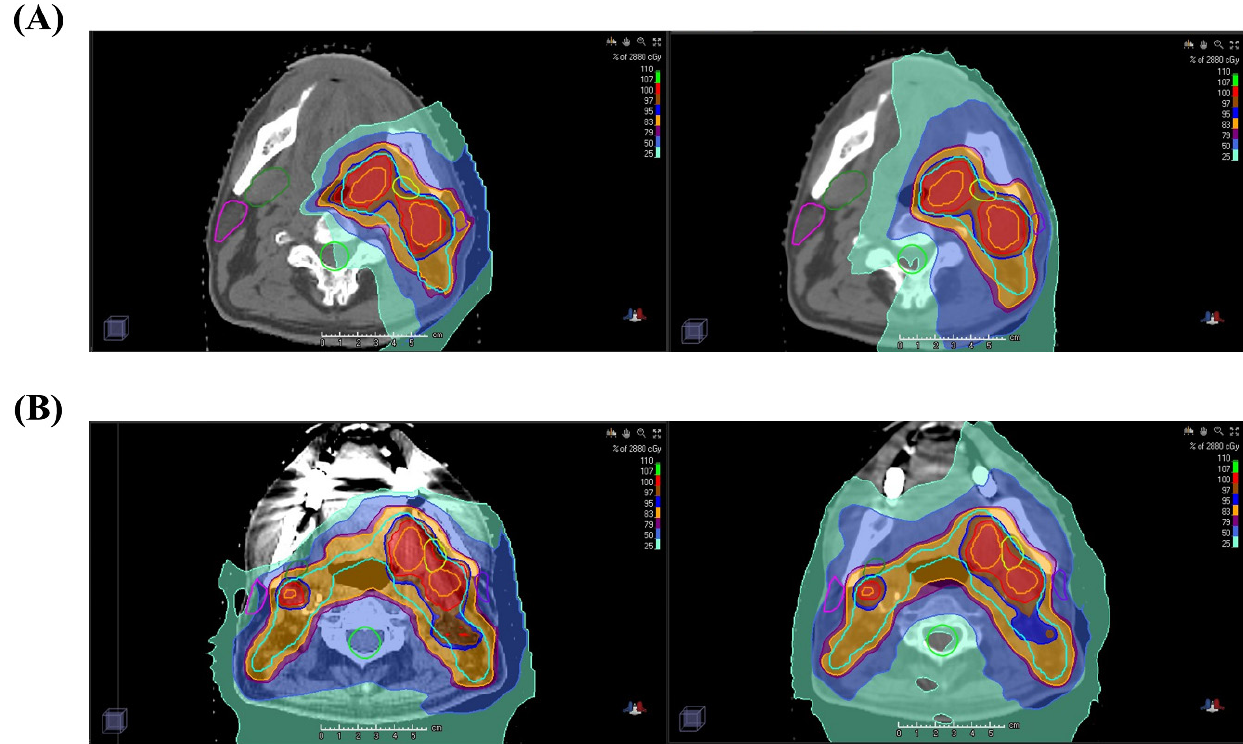
Figure 3. Comparison of dose distribution on axial view between IMRT/IMPT combination (left) and IMRT only (right) in unilateral ( A ) and bilateral ( B ) neck irradiation cases. The areas corresponding to 100%, 97%, 95%, 50% and 25% of the prescribed dose are visualized as red, brown, indigo, blue, and aquamarine colors, respectively. IMRT, Intensity-Modulated Radiation Therapy; IMPT, Intensity - Modulated Proton Therapy.